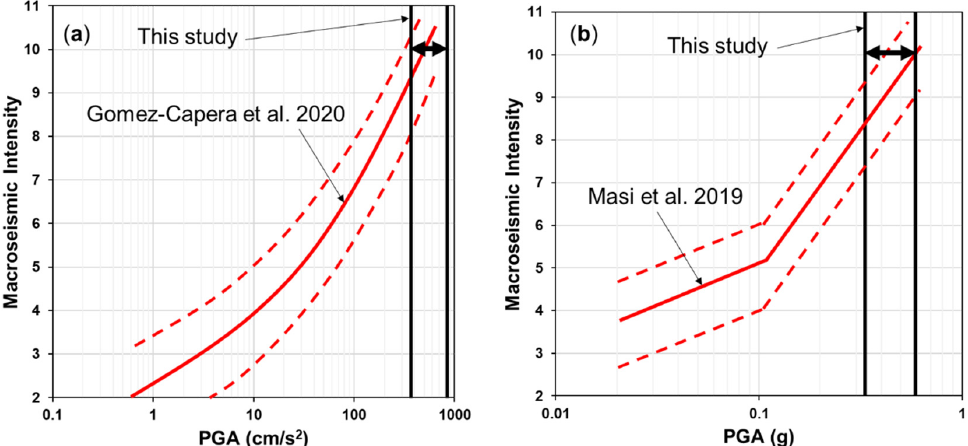
Figure 20. Vertical profiles of maximum acceleration obtained from the equivalent linear analyses. Rollins et al (2020) [96]; Modoni & Gazellone (2010) [95]; Menq (2003) [94]; Rollins et al (1994) [93]; Kukusho et al. (1981) [92].